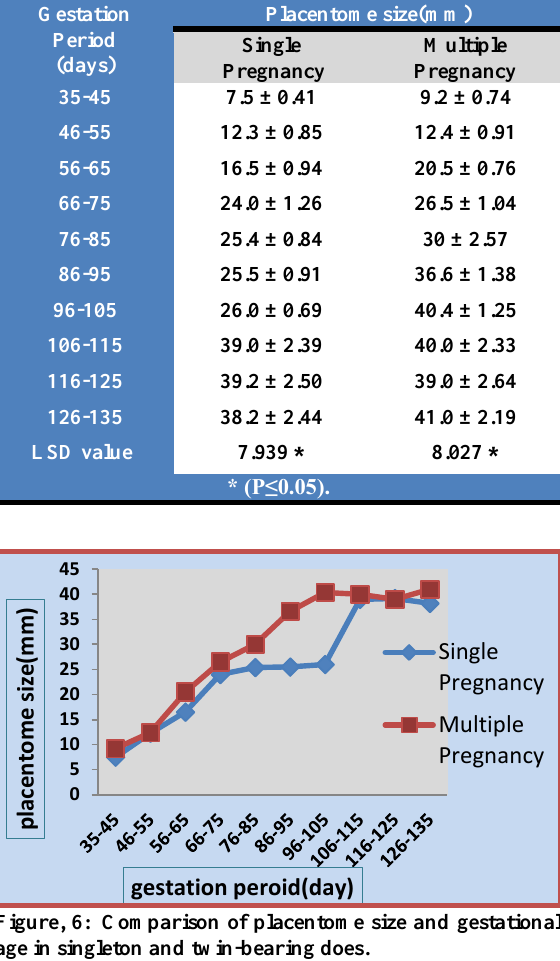
Table, 2: Comparison of placentomes diameter and gestational in single and Multiple-bearing goats .